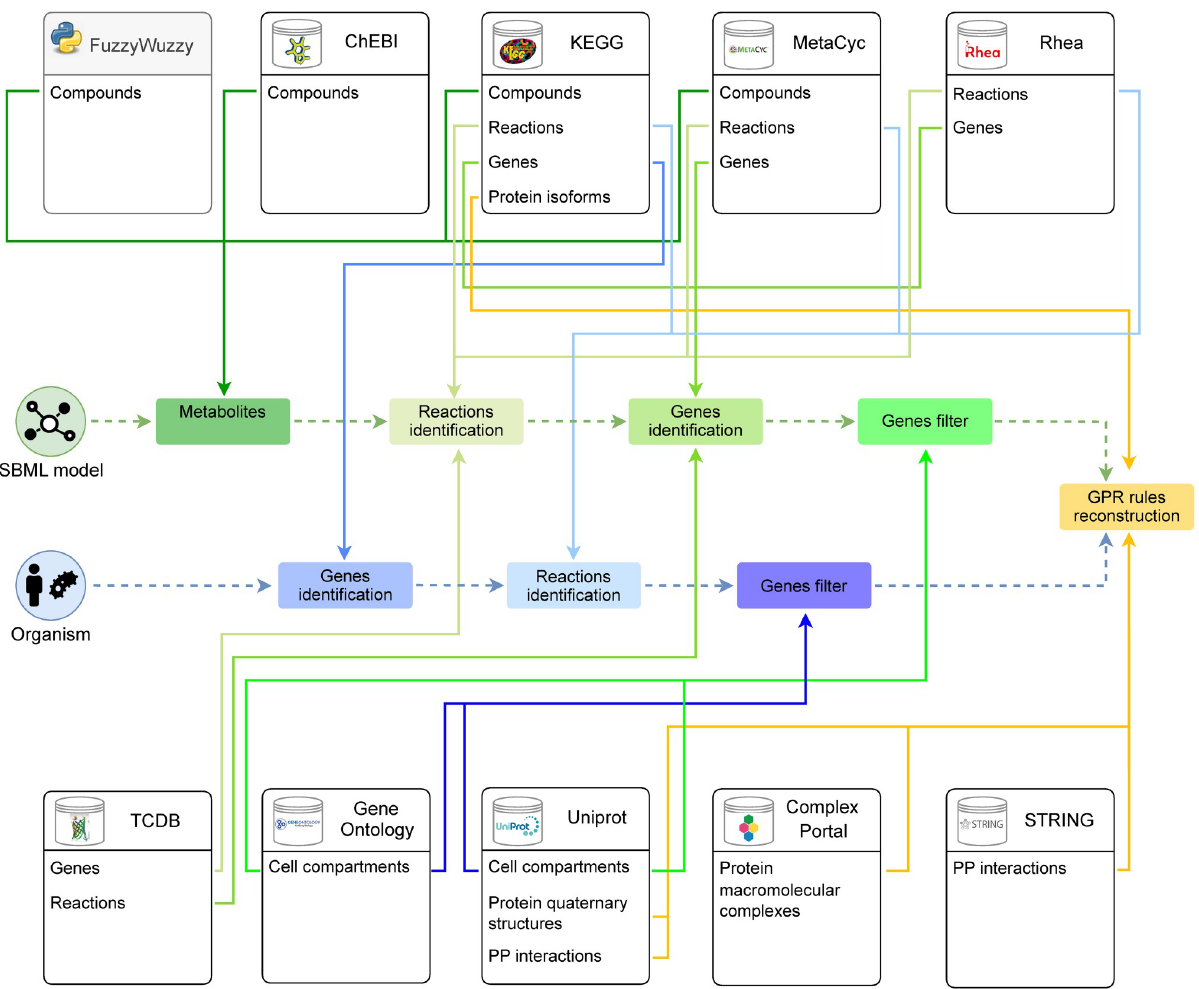
Fig 3. A detailed graphical representation of GPRuler tool. The central part of the figure illustrates the two alternative paths that can be followed to reconstruct the GPR rules according to the two possible inputs of GPRuler : the SBML model (green) and the organism name (blue). The green and the blue rectangles connected to each other by dashed arrows show the steps to follow in each path to achieve the core pipeline (orange rectangle), which returns as ultimate outcome the GPR rules. The ten boxes on the top and bottom of the figure represent the exploited data sources used by GPRuler , including both biological databases (white boxes) and the FuzzyWuzzy Python package (gray box), listing which information is retrieved from each of them. Each coloured arrow links each step of the pipeline to the used source and, in particular, to the type of data for which that particular source is